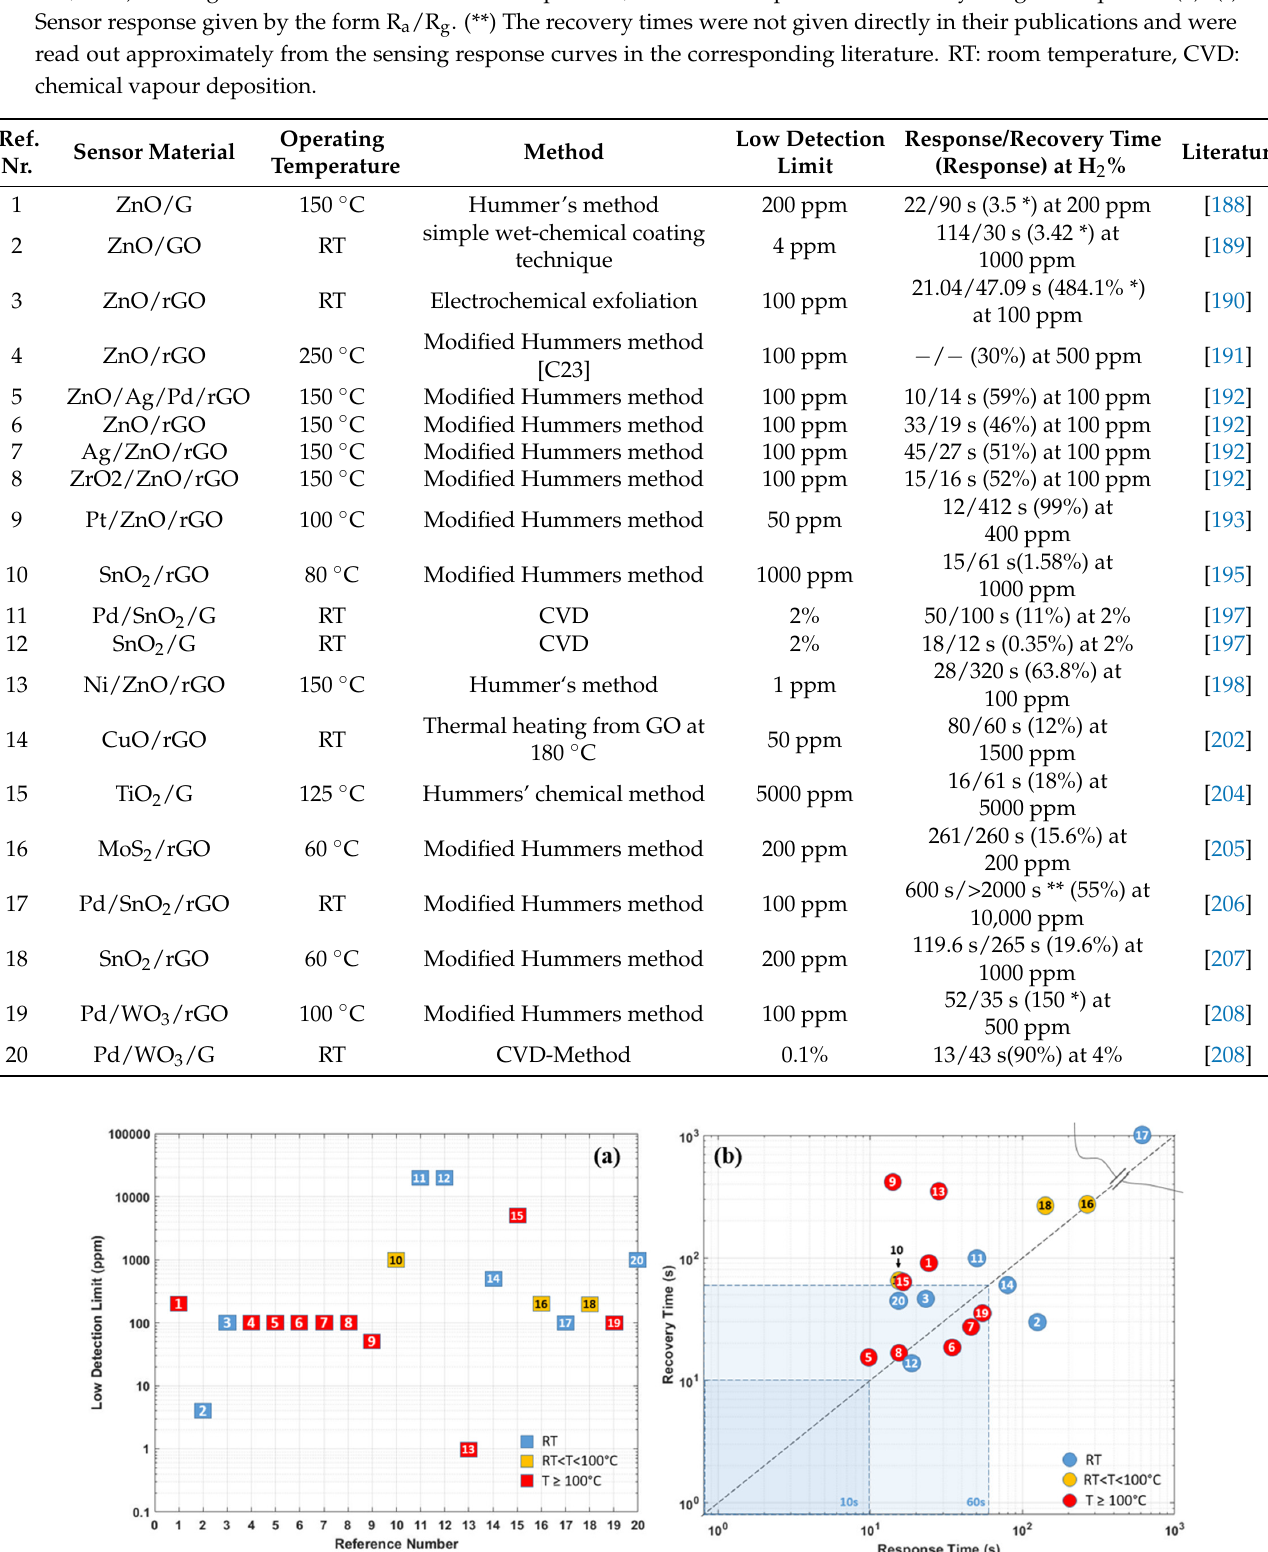
Figure 48. Regarding to Table 4, schematic illustrations of the comparison of the reported: ( a ) low detection limits. The x-axis “Reference Number” represents the 1st column“Ref. Nr.“ in Table 4. ( b ) Response time/recovery time under experimental conditions in literature.